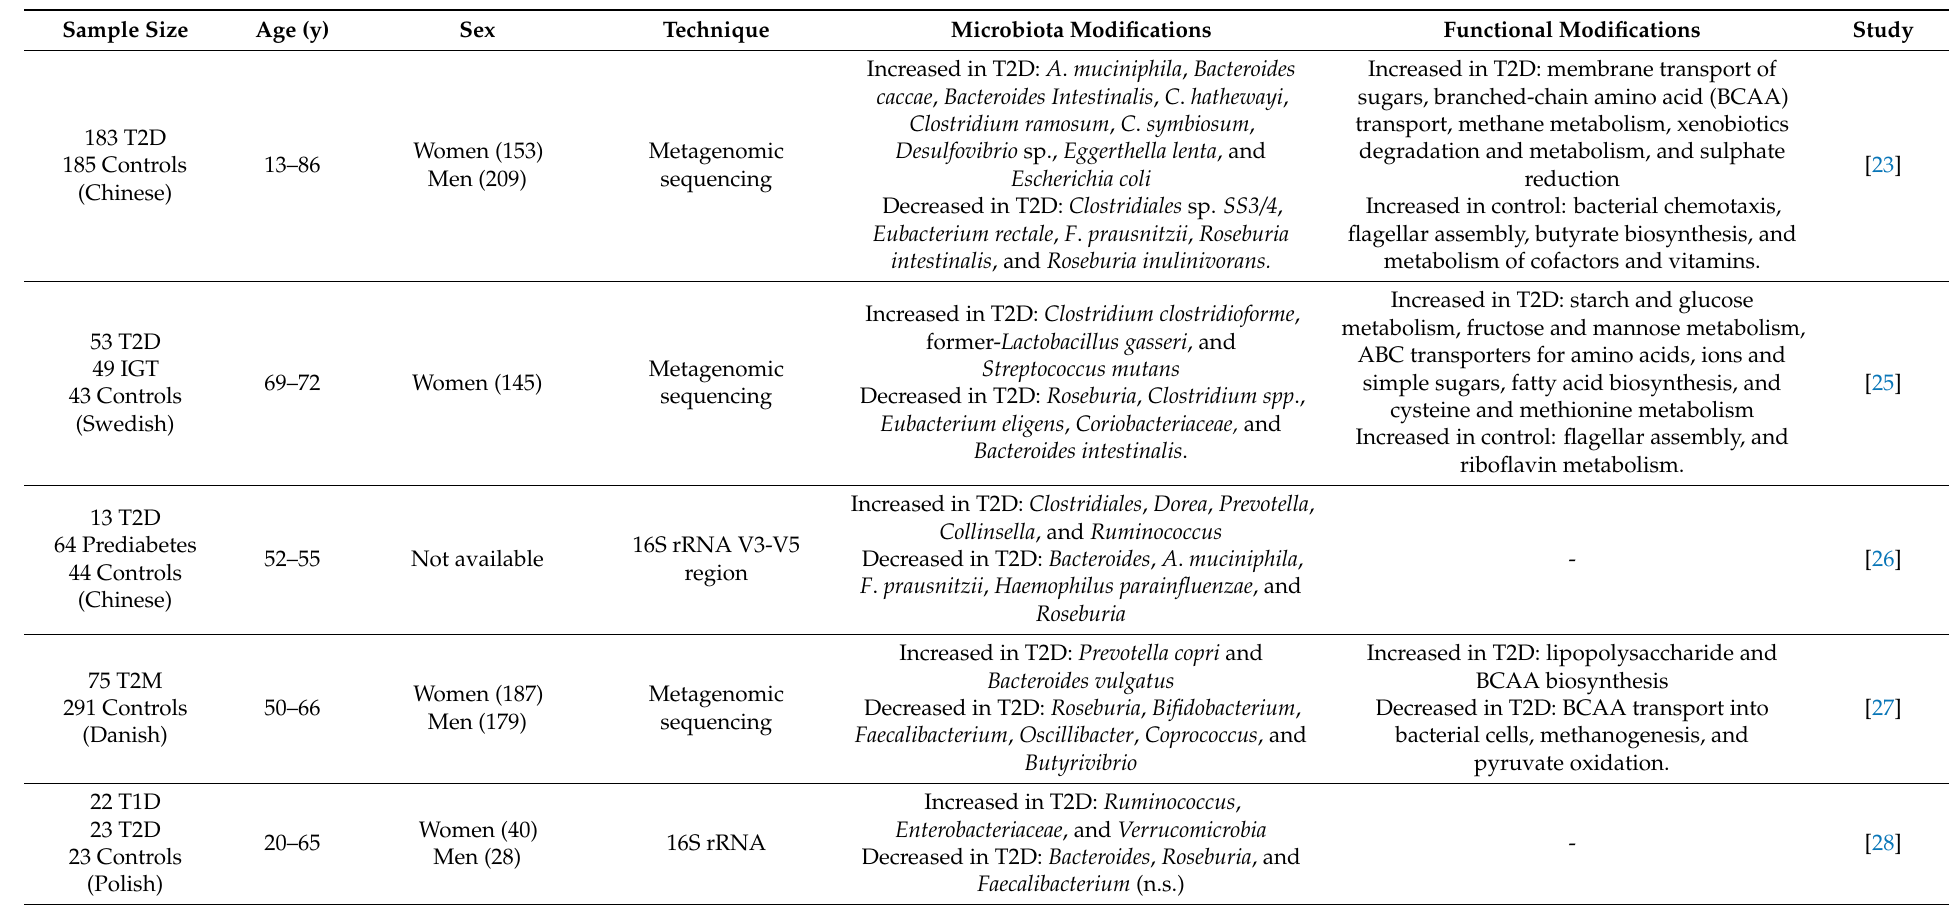
Table 1. Summary of studies evaluating microbial and functional changes in individuals with